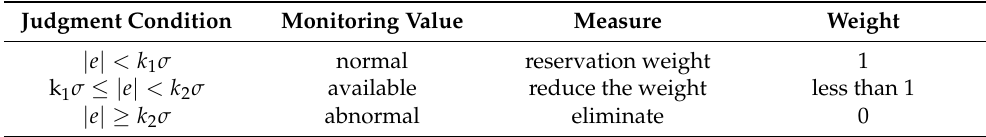
Table 2. Treatment measure of IGG method